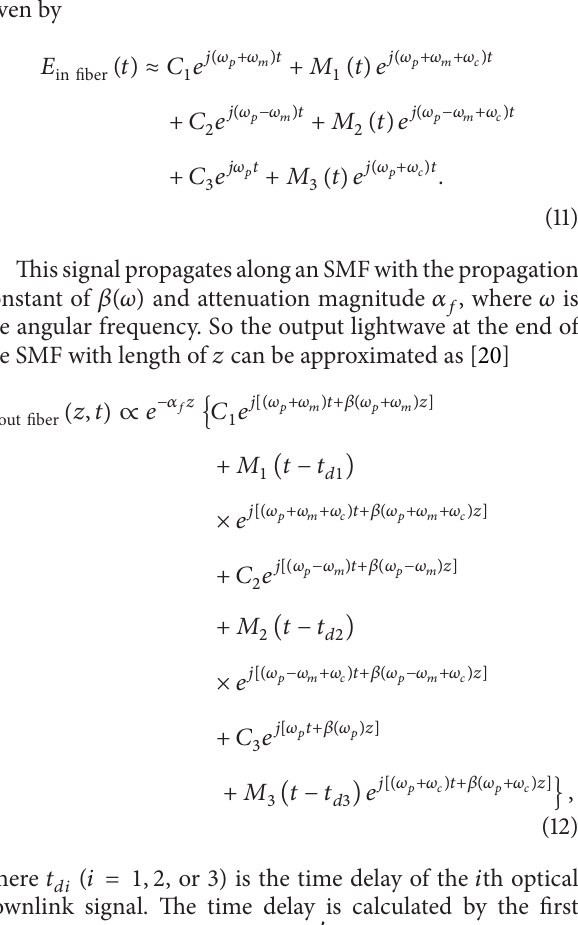
𝑖 th optical downlink carrier frequency. The output lightwave at the end of fiber is considered as three optical signals with different downlink frequencies of 𝜔 𝑝 + 𝜔 𝑚 , 𝜔 𝑝 − 𝜔 𝑚 , and 𝜔